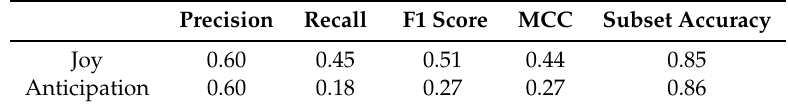
Accuracy of fine-tuned settings in Bag-of-Words representation, Multi-nominal Naive Bayes classifier.